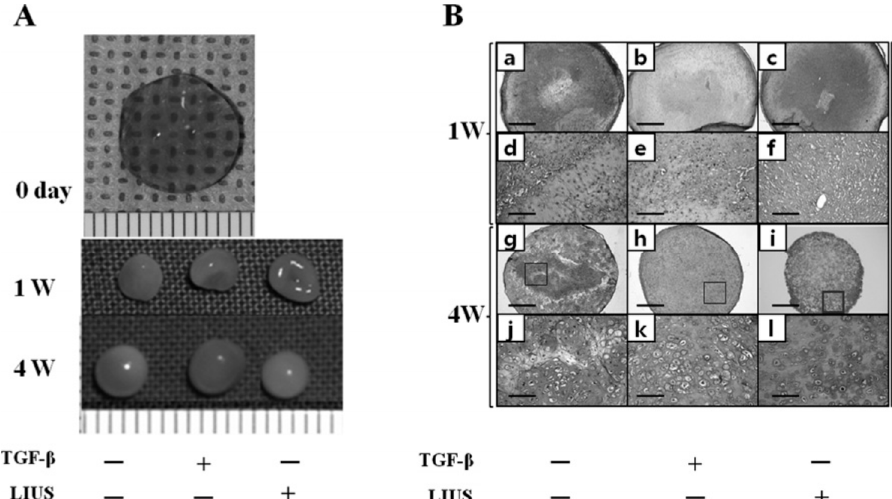
Figure 9. Effect of low-intensity ultrasound (LIUS) on the chondrogenesis of rabbit MSCs seeded in fibrin-HA and cultured in chondrogenic-defined medium untreated, treated with TGF- β 3 (10 ng/mL), or treated with LIUS (100 mW/cm 2 ) for 1 and 4 weeks, ( A ) the gross images of the constructs at 0, 1, and 4 weeks in scale bar of 1 mm; and ( B ) images of safranin-O/fast green staining in scale bar of 1 mm for ( a – c , g – i ), 200 mm for ( d – f , j – l ), courtesy of [120].